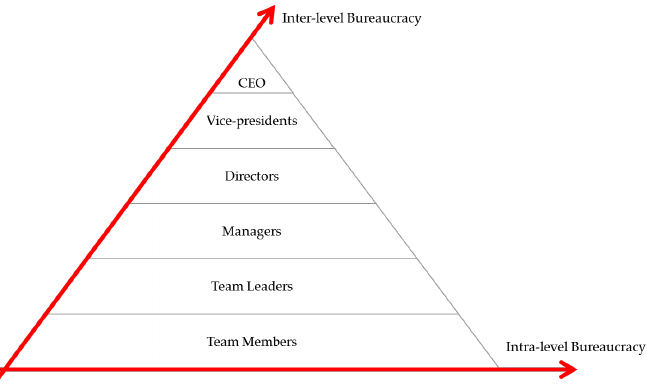
Fig. 3. Simplified illustration of IdeaSquare’s paradigm of “organizations as productivity pyramids”. Inter-layer departments are omitted. The arrows indicate the two directions where the Lindeman’s 10% rule